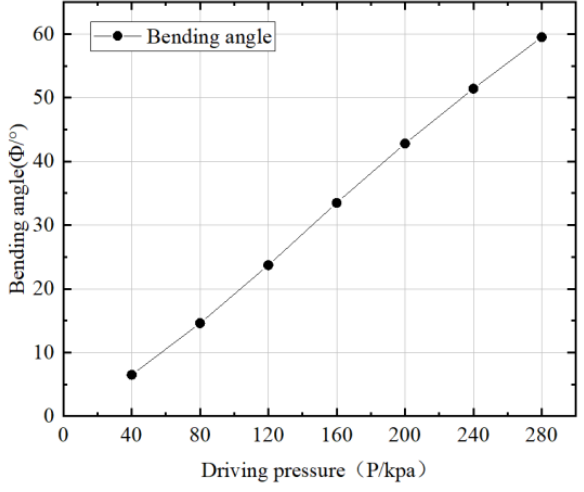
Figure 6. Bending angle – driving pressure curve of the hexagonal prism soft-bodied bionic actuator.